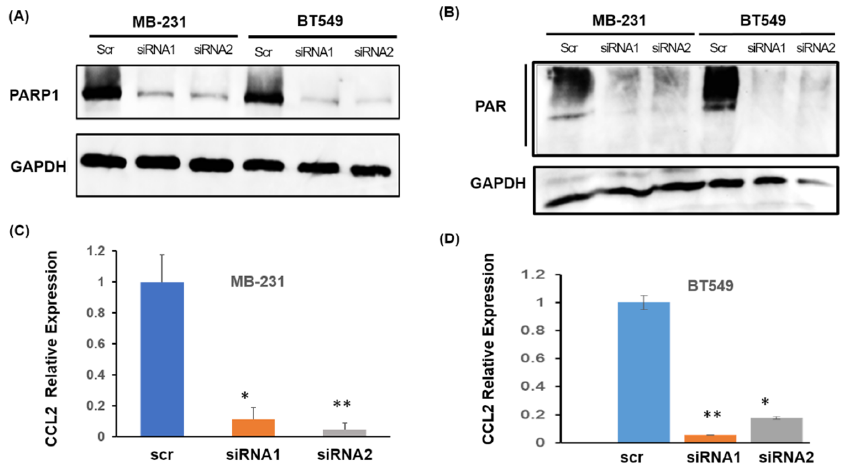
Figure 2. siRNA mediated PARP1 knockdown downregulates CCL2 transcription. ( A ) Western blot for Total PARP1. Knockdown efficiency with PARP1 RNAi is confirmed with two different PARP1 siRNAs in MB-231and BT549 cells. ( B ) Western blot showing the total PAR level in the two breast cancer cells with siRNA mediated PARP1 knockdown. GAPDH is shown as a loading control. ( C ) Relative expression of CCL2 mRNA upon siRNA mediated PARP1 knockdown in MB-231 and ( D ) BT549 cells (Right). For ( C ) and ( D ), RNA was harvested after 72 h post-transfection. siRNA knockdown was performed independently twice. Polymerase chain reaction (PCR) was performed twice in triplicates, data presented as ± S.E.M., * p < 0.0004 ** p < 0.0001 with one way ANOVA and Tukey’s comparison with scrambled siRNA. Whole western blots for 2A and 2B are in Figure S9. 2.4. PAR Level Is Associated with CCL2 Transcription in Breast Cancer Next, we asked whether PARP1 enzymatic activity is associated with CCL2 mRNA levels. To this end, we used PJ34 to inhibit PARP1. We examined the PAR level as a surrogate for PARP1 activity. As seen in Figure 3A, PJ34 treatment resulted in a reduction in total PAR levels in MB-231 cells in western blots (Left panel). Concurrently, a decrease in CCL2 transcript level was observed in a dose-dependent manner when treated with 5 and 10 µM PJ34 (Figure 3A Right Panel). We also used enzyme-Linked Immunosorbent Assay (ELISA) to measure secreted CCL2 protein in cell-conditioned media. With 10 µM PJ34 treatment overnight, the total amount CCL2 in the cell-conditioned media significantly decreased from 4094 pg/mL to 1562 pg/mL (Figure 3B). Thus, inhibiting PARP1 resulted in lower CCL2 levels. We also observed the downregulation of CCL2 mRNA in BRCA1 mutated TNBC cell lines HCC1937 and MDA-MB-436 cells with PJ34 treatment (Figure S4A). While CCL2 levels were decreased in both cell lines, we found an 80% to 90% reduction in CCL2 in the HCC1937 cells. In the HCC1937 cells, PARP1 was also localized to the CCL2 promoter as seen by chromatin immunoprecipitation with PARP1 antibody (Figure S4B). We then asked whether increasing overall PAR levels can affect CCL2 levels. To this end, we utilized Poly-ADP-ribose glycohydrolase (PARG) inhibitors to treat MB-231 cells. Since PARG is a hydrolase that de-PARylates proteins by removing PAR moiety, we hypothesized that PARG inhibition would increase CCL2 transcript [14]. Interestingly, treating MB-231 cells with PDD00017273 (PARGi) resulted in increased PARylation (Figure 3C left) [15]. Interestingly, CCL2 transcript levels increased with both 5 µM and 10 µM PARGi doses (~50% increase, p < 0.05) along with an increase in PARylation (Figure 3C right panel). Next, we asked whether PARG treatment can prevent PJ34 mediated downregulation of the CCL2 mRNA. To this end, we subjected MB-231 cells to treatment with both PJ34 and PARGi. Cells were pretreated with 10 µM PJ34 overnight, followed by PARGi at a 5 µM dose. Interestingly, PARGi and PJ34 treatment resulted in an increased expression of CCL2 compared to PJ34 alone (Figure 3D). Thus, PARG inhibition partially rescued PJ34 mediated downregulation of CCL2 , suggesting a positive correlation between CCL2 transcription and PARylation in the breast cancer cells.